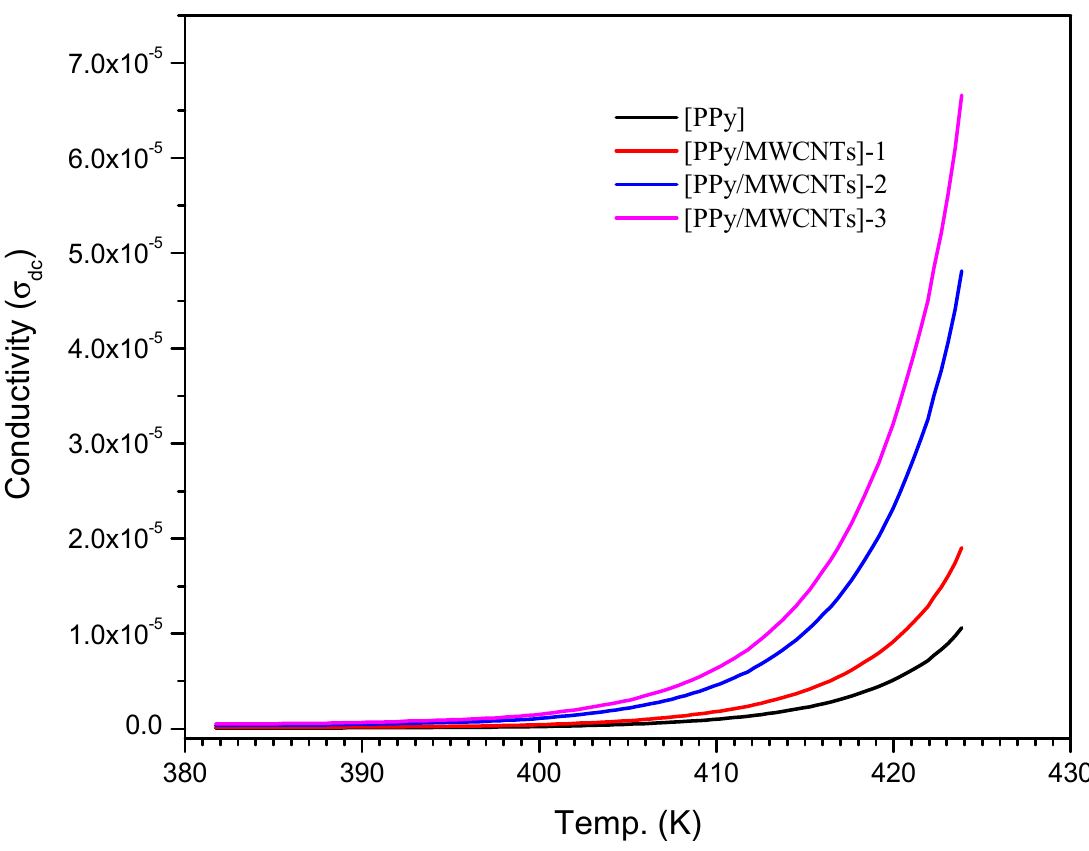
Figure 10. The dependence of direct current (DC) conductivity of PPy, [PPy/MWCNTs]-1, [PPy/MWCNTs]-2, and [PPy/MWCNTs]-3 on temperature (T).